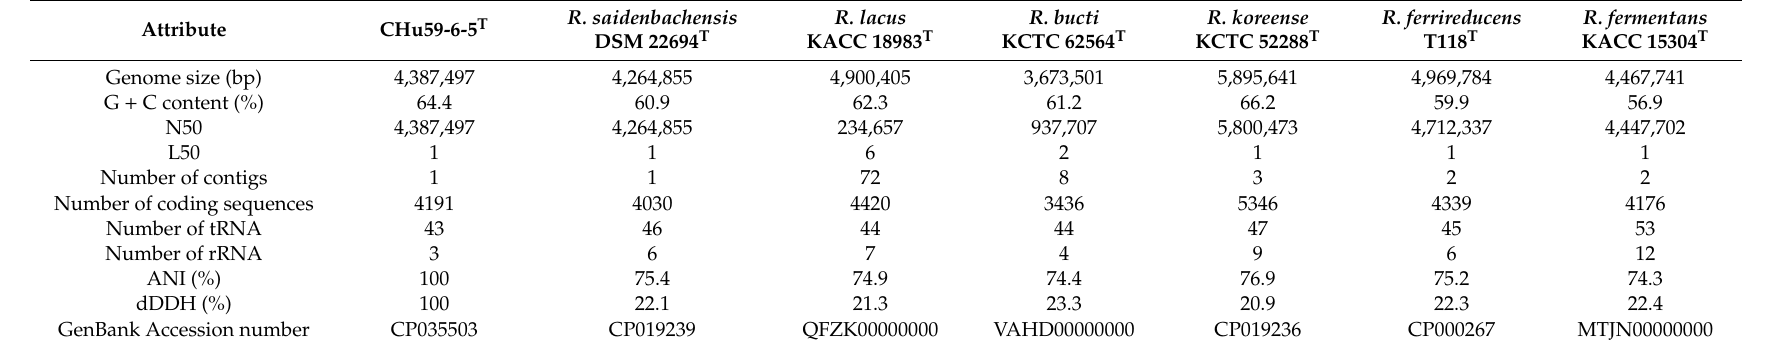
Table 3. General features, and relationship of the genomes between strain CHu59-6-5 T and strains of its closely related species of the genus Rhodoferax